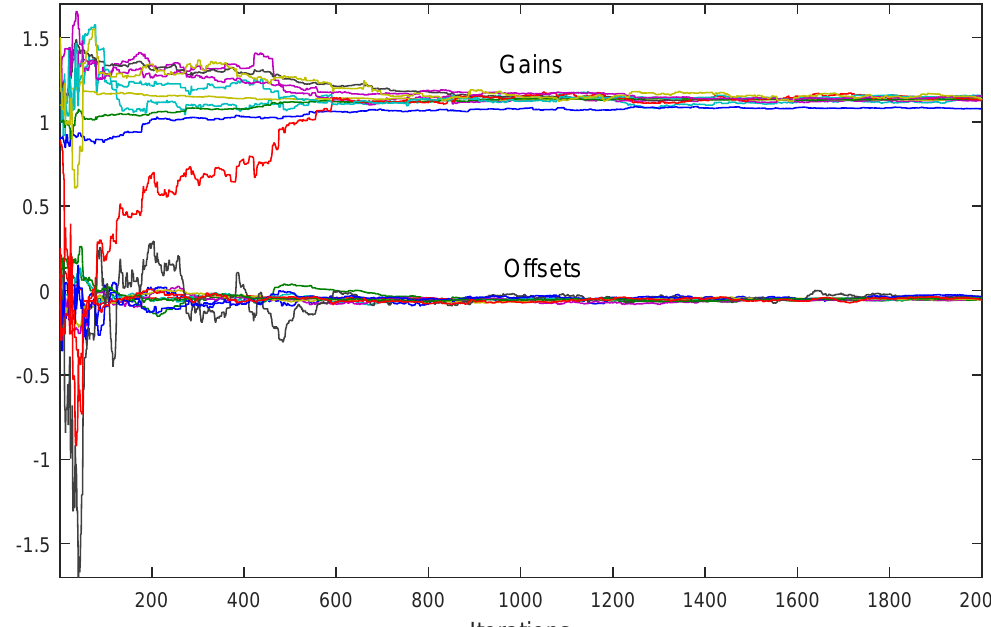
Figure 6. The asynchronous algorithm based on instrumental variables without reference sensors: convergence to consensus is achieved for corrected gains and corrected offsets.